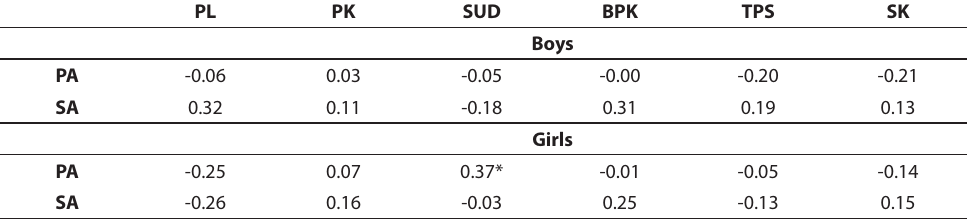
TABLE 2 Correlation coefficient with significance motor skill assessment tests for the variables of physical activity and sedentary activities in boys and